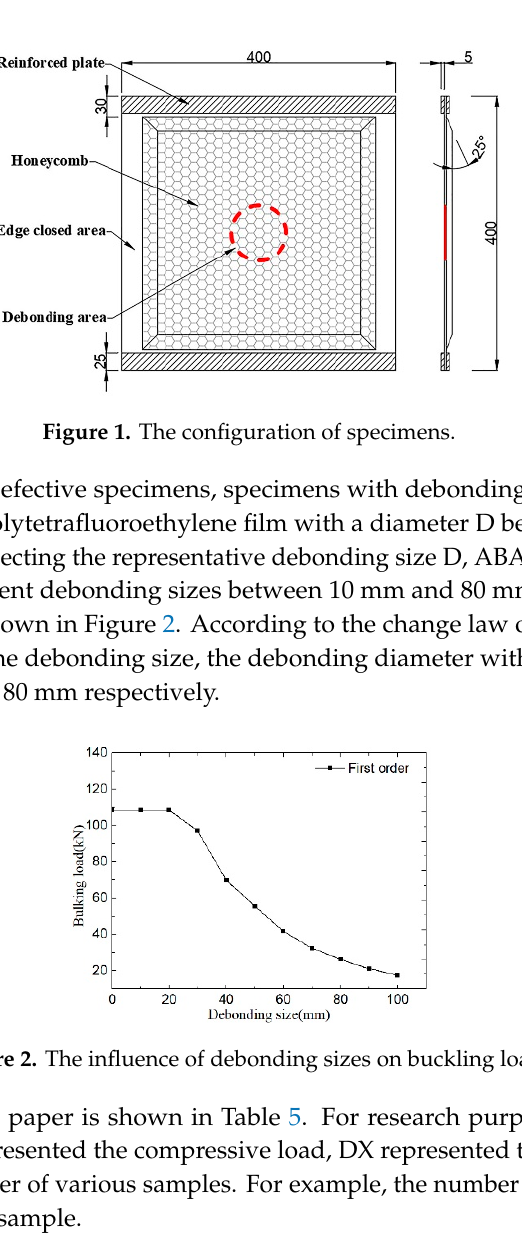
Table 4. The design basis of specimens.